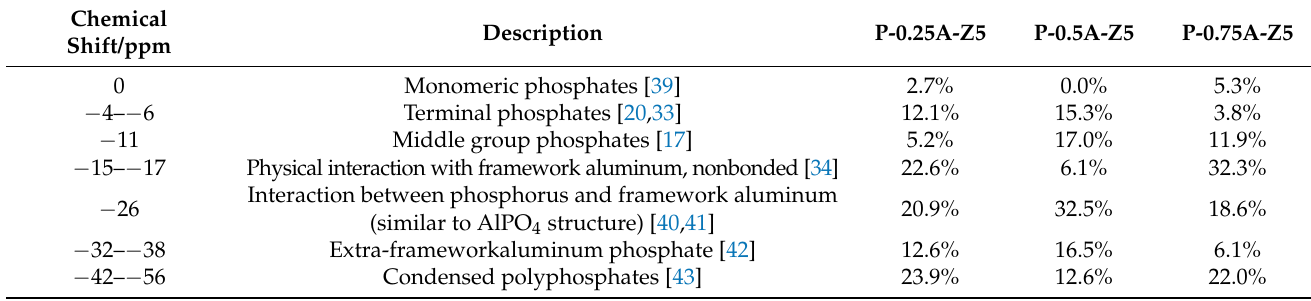
Table 6. Integral peak-fitting results of 31 P MAS NMR for the P-xA-Z5 samples.